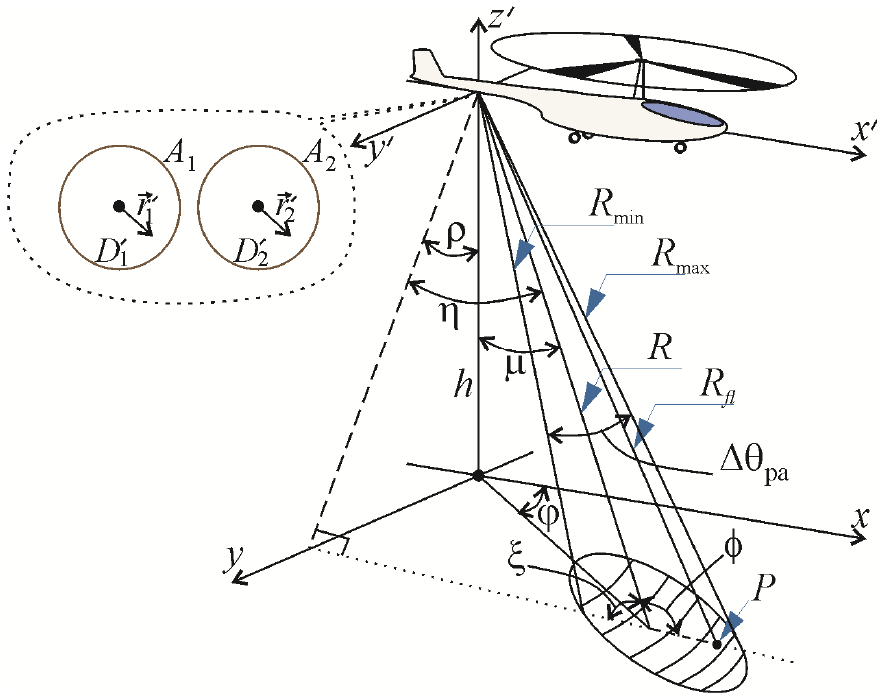
Figure 1. Primary geometry of the problem with marked physical parameters and geometric relationships for one radiation pattern beam.